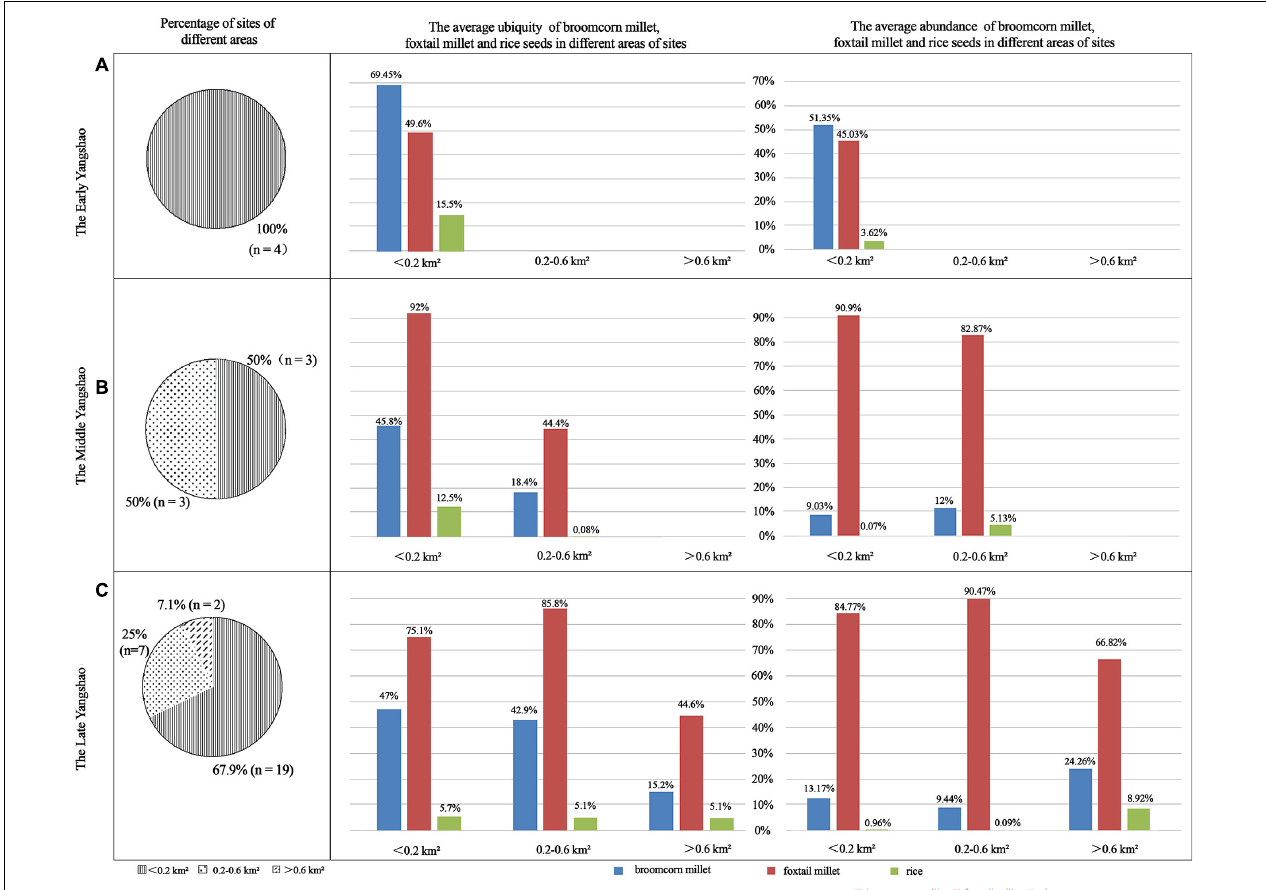
FIGURE 5 | Histograms of the ubiquity and abundance of broomcorn millet, foxtail millet, and rice according to site size in the (A) Early, (B) Middle, and (C) Late